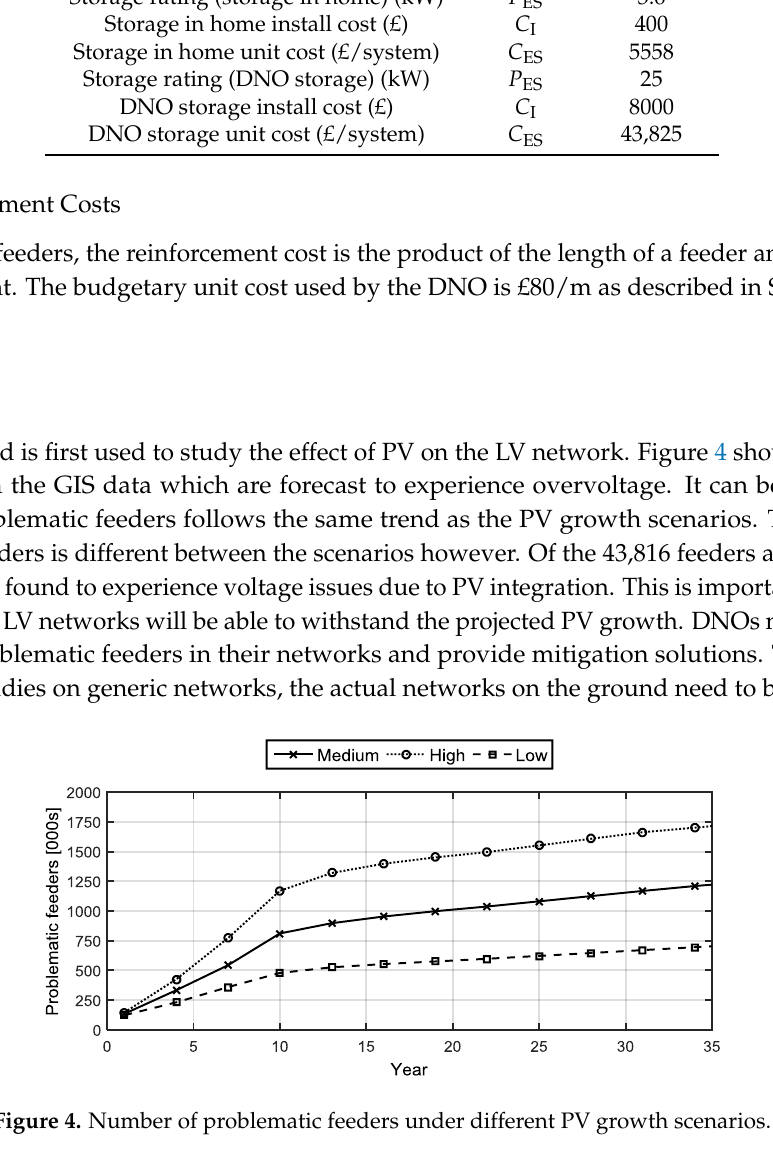
Table 3. Summary of energy storage cost parameters.